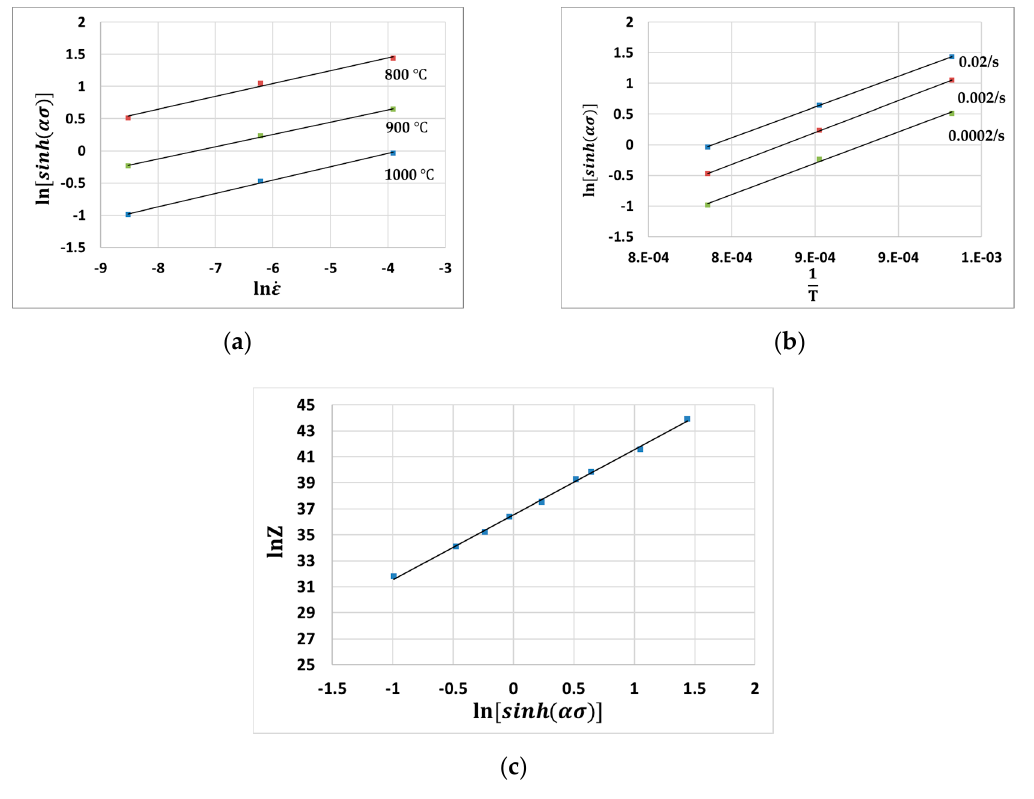
(cid:16) (cid:17) . ε − (cid:4667) ( c ) ln𝜀(cid:4662) − ln (cid:4670)sinh(cid:4666)𝛼𝜎(cid:4667)(cid:4671) plot when strain is 0.3. 1 ( c ) ln ln [ sinh ( ασ )] plot when strain is 0.3. (cid:3021) T